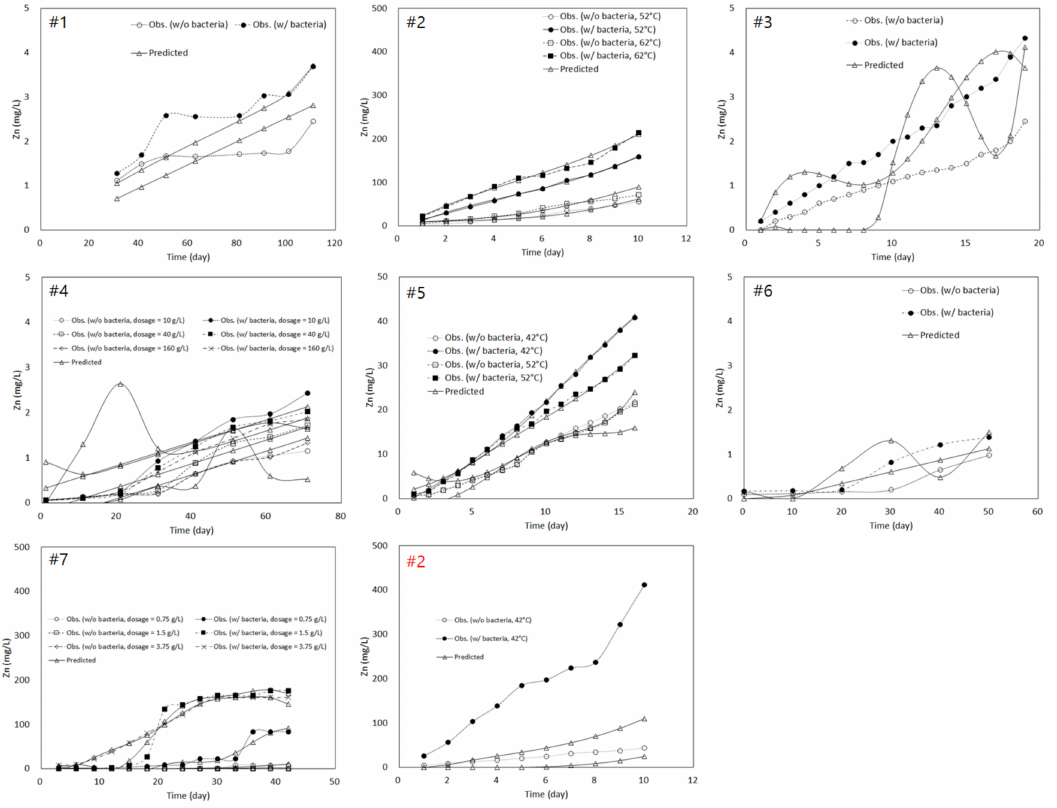
Figure 7. Observed and ANN-predicted Zn concentration changes with a topology of 9:10:1. The numbers are from Table 1, while the red number is the result from the data for further